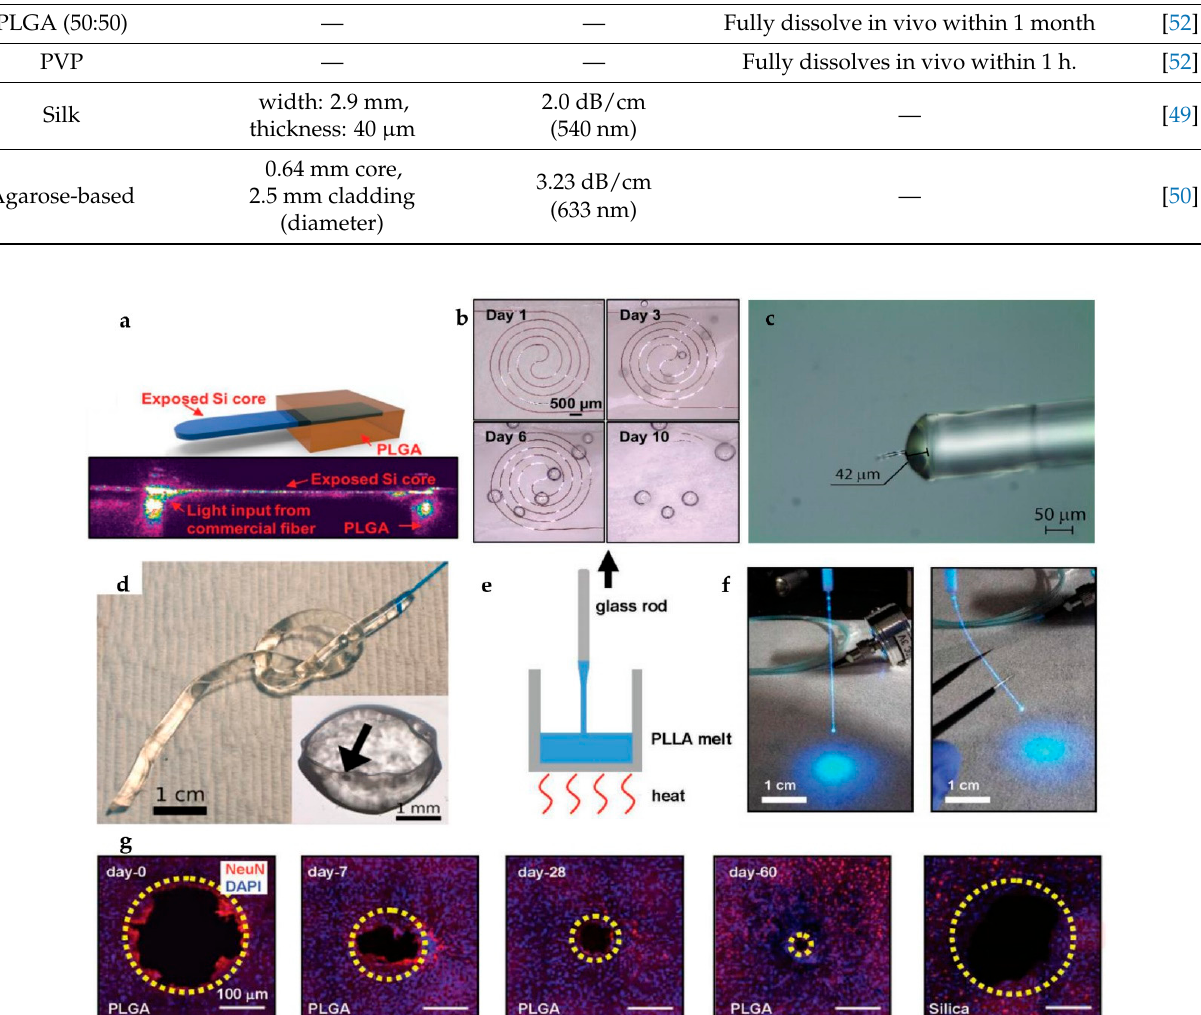
Figure 1. ( a ) Schematic illustration of a silicon nanomembrane-based optical waveguide encapsulated with PLGA ( top ) and optical image of the silicon nanomembrane-based optical waveguide ( bottom ). ( b ) Optical image of the dissolution process of a typical silicon-based optical waveguide in PBS at 70 °C). ( a , b ) Reproduced with permission from [20]. ( c ) Optical image of a phosphate glass-based optical fiber. Reproduced with permission from [73]. ( d ) Optical photographs of a silk-based optical fiber. Reproduced with permission from [49]. ( e ) Schematic illustration of the fabrication process of PLLA-based optical fibers. ( f ) Optical images of a PLLA fiber that transmits light at straight ( left ) and bending ( right ) states. ( g ) Time scale dissolution process of a PLGA-based optical waveguide in PBS (pH = 7.4, 37 °C). The dissolution of a PLLA fiber reduces the areas of lesion (highlighted with yellow dotted circle). The right panel shows a silica-based waveguide implanted into a brain at the same conditions as a comparison. ( e – g ) Reproduced with permission from [51]. Table 2. Optical loss and degradation rate of common biodegradable optical waveguides. Materials